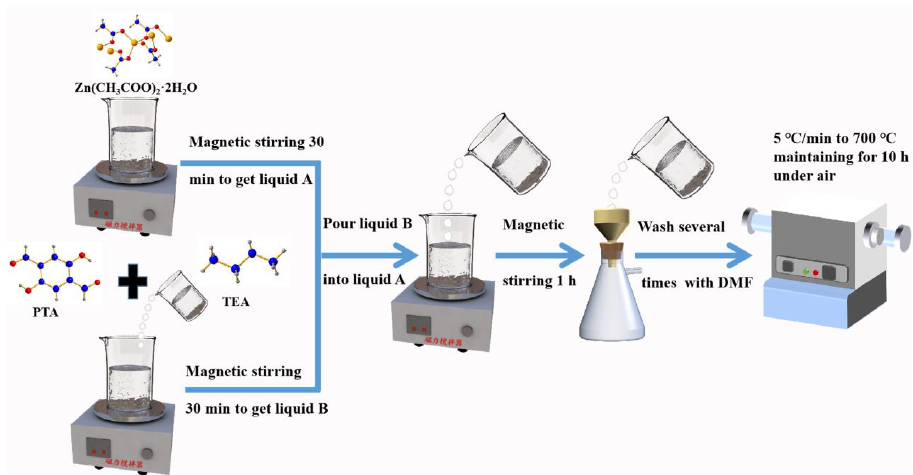
Figure 1. Schematic illustration for synthesizing ZnO nanoparticles.